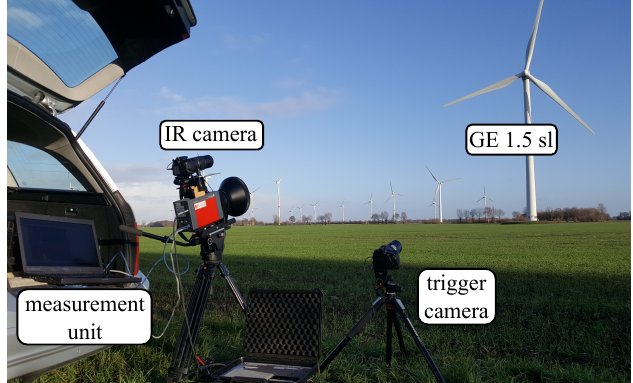
Figure 5. Experimental set-up for field measurements for the thermographic flow visualization containing an IR-camera, an optical trigger camera and the measurement